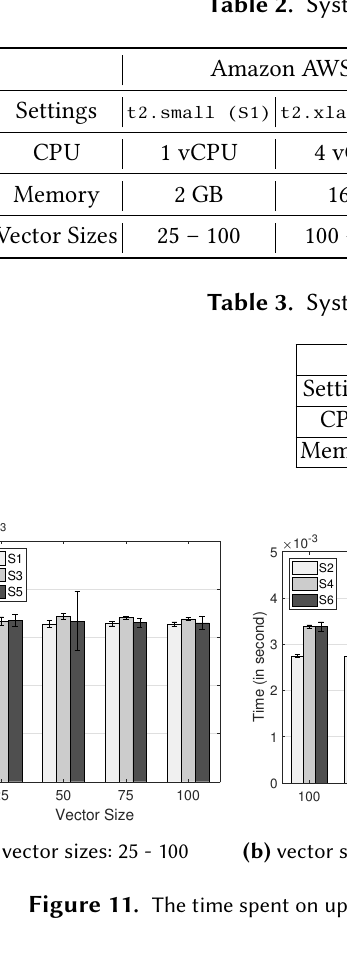
achieve similar performance, regardless of the configuration of